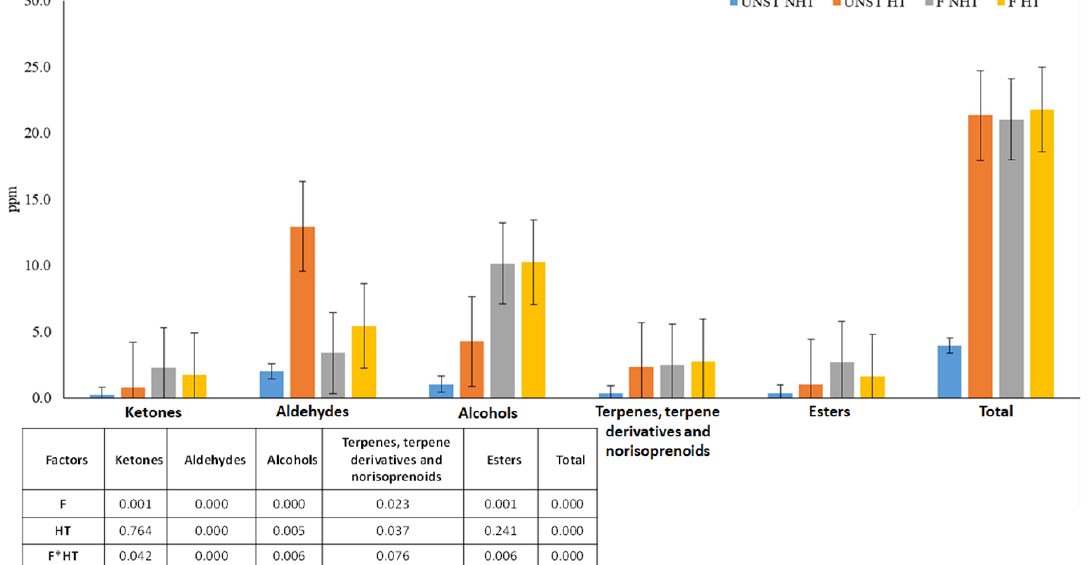
Figure 2. E ff ect of thermal treatment and of fermentation on volatile composition of apple pomace. Figure 2. Effect of thermal treatment and of fermentation on volatile composition of apple pomace. Figure 2. Effect of thermal treatment and of fermentation on volatile composition of apple pomace. Figure 2. Effect of thermal treatment and of fermentation on volatile composition of apple pomace. Figure 2. Effect of thermal treatment and of fermentation on volatile composition of apple pomace. Figure 2. Effect of thermal treatment and of fermentation on volatile composition of apple pomace. Two-way ANOVA, Tukey’s test ( p ≤ 0.05). UNST NHT: unstarted not heated apple pomace ( Two-way ANOVA, Tukey’s test ( p ≤ 0.05). UNST NHT: unstarted not heated apple pomace ( ); UNST Two-way ANOVA, Tukey’s test ( p ≤ 0.05). UNST NHT: unstarted not heated apple pomace ( ); UNST Two-way ANOVA, Tukey’s test ( p ≤ 0.05). UNST NHT: unstarted not heated apple pomace ( ); UNST Two-way ANOVA, Tukey’s test ( p ≤ 0.05). UNST NHT: unstarted not heated apple pomace ( ); UNST Two-way ANOVA, Tukey’s test ( p ≤ 0.05). UNST NHT: unstarted not heated apple pomace ( ); UNST HT: unstarted heated apple pomace ( ); F NHT: Lactobacillus rhamnosus 1473 fermented not heated HT: unstarted heated apple pomace ( ); F NHT: Lactobacillus rhamnosus 1473 fermented not heated HT: unstarted heated apple pomace ( ); F NHT: Lactobacillus rhamnosus 1473 fermented not heated HT: unstarted heated apple pomace ( ); F NHT: Lactobacillus rhamnosus 1473 fermented not heated HT: unstarted heated apple pomace ( ); F NHT: Lactobacillus rhamnosus 1473 fermented not heated apple pomace ( ); F HT: Lactobacillus rhamnosus 1473 fermented heated apple pomace ( ). apple pomace ( ); F HT: Lactobacillus rhamnosus 1473 fermented heated apple pomace ( ). apple pomace ( ); F HT: Lactobacillus rhamnosus 1473 fermented heated apple pomace ( apple pomace ( ); F HT: Lactobacillus rhamnosus 1473 fermented heated apple pomace ( ). apple pomace ( ); F HT: Lactobacillus rhamnosus 1473 fermented heated apple pomace ( ).